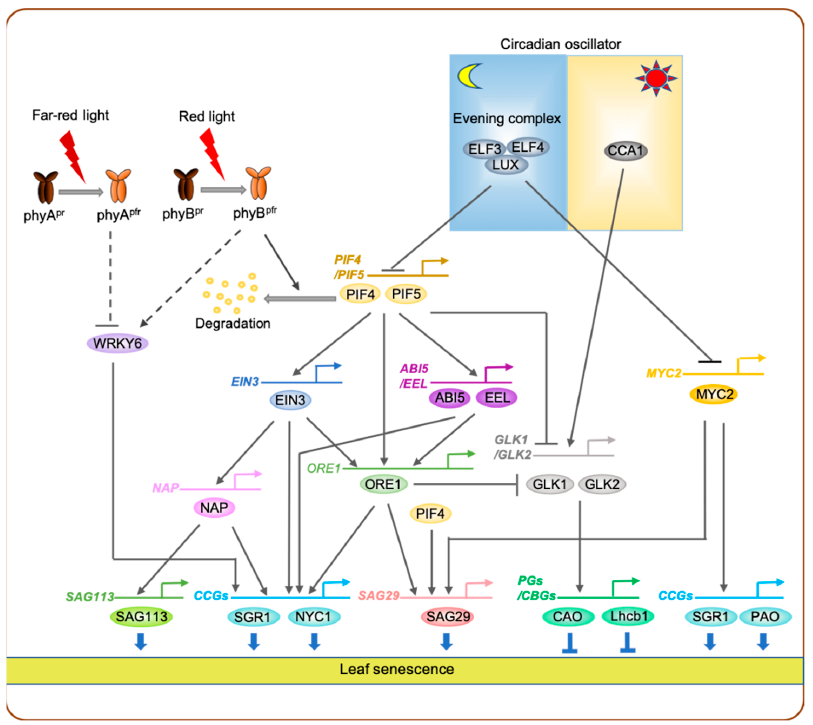
Figure 2. Transcriptional regulatory network of leaf senescence regulated by light signaling. Un- der red light, PIF4 and PIF5 are degraded through a phyB-mediated proteasomal degradation pathway, leading to the inactivation of PIF-dependent promotion of leaf senescence. In darkness, however, phyB exists in the inactive Pr state, which allows PIF4 and PIF5 to activate the expression of ETHYLENE INSENSITIVE3 ( EIN3 ), ABSCISIC ACID INSENSITIVE 5 ( ABI5 ), and EN- HANCED EM LEVEL ( EEL ) . Then PIFs, together with EIN3, ABI5, and EEL, form a feedforward loop to activate the expression of ORE1 . Among the proteins that act downstream of PIF4 and PIF5, ORE1 is involved in feedforward loops that activate genes, encoding chlorophyll degradation enzymes, repressing GOLDEN2-LIKE ( GLK ) genes, which encode transcriptional activators of photosynthesis and chlorophyll biosynthesis-related genes. In the circadian oscillator, the EARLY FLOWERING3 (ELF3)–ELF4–LUX evening complex (EC) represses the expression of PIF4 and PIF5 as well as that of MYC2 , which encodes a key TF involved in jasmonate signaling, while CIRCADIAN CLOCK ASSOCIATED 1 (CCA1), a core component of the circadian oscillator, activates the expression of GLK genes and represses the expression of ORE1 . WRKY6 , which encodes a senescence-associated WRKY TF, is negatively and positively regulated by phyA- and phyB-mediated signaling pathways, respectively. Solid lines indicate direct regulation, while dashed lines indicate indirect